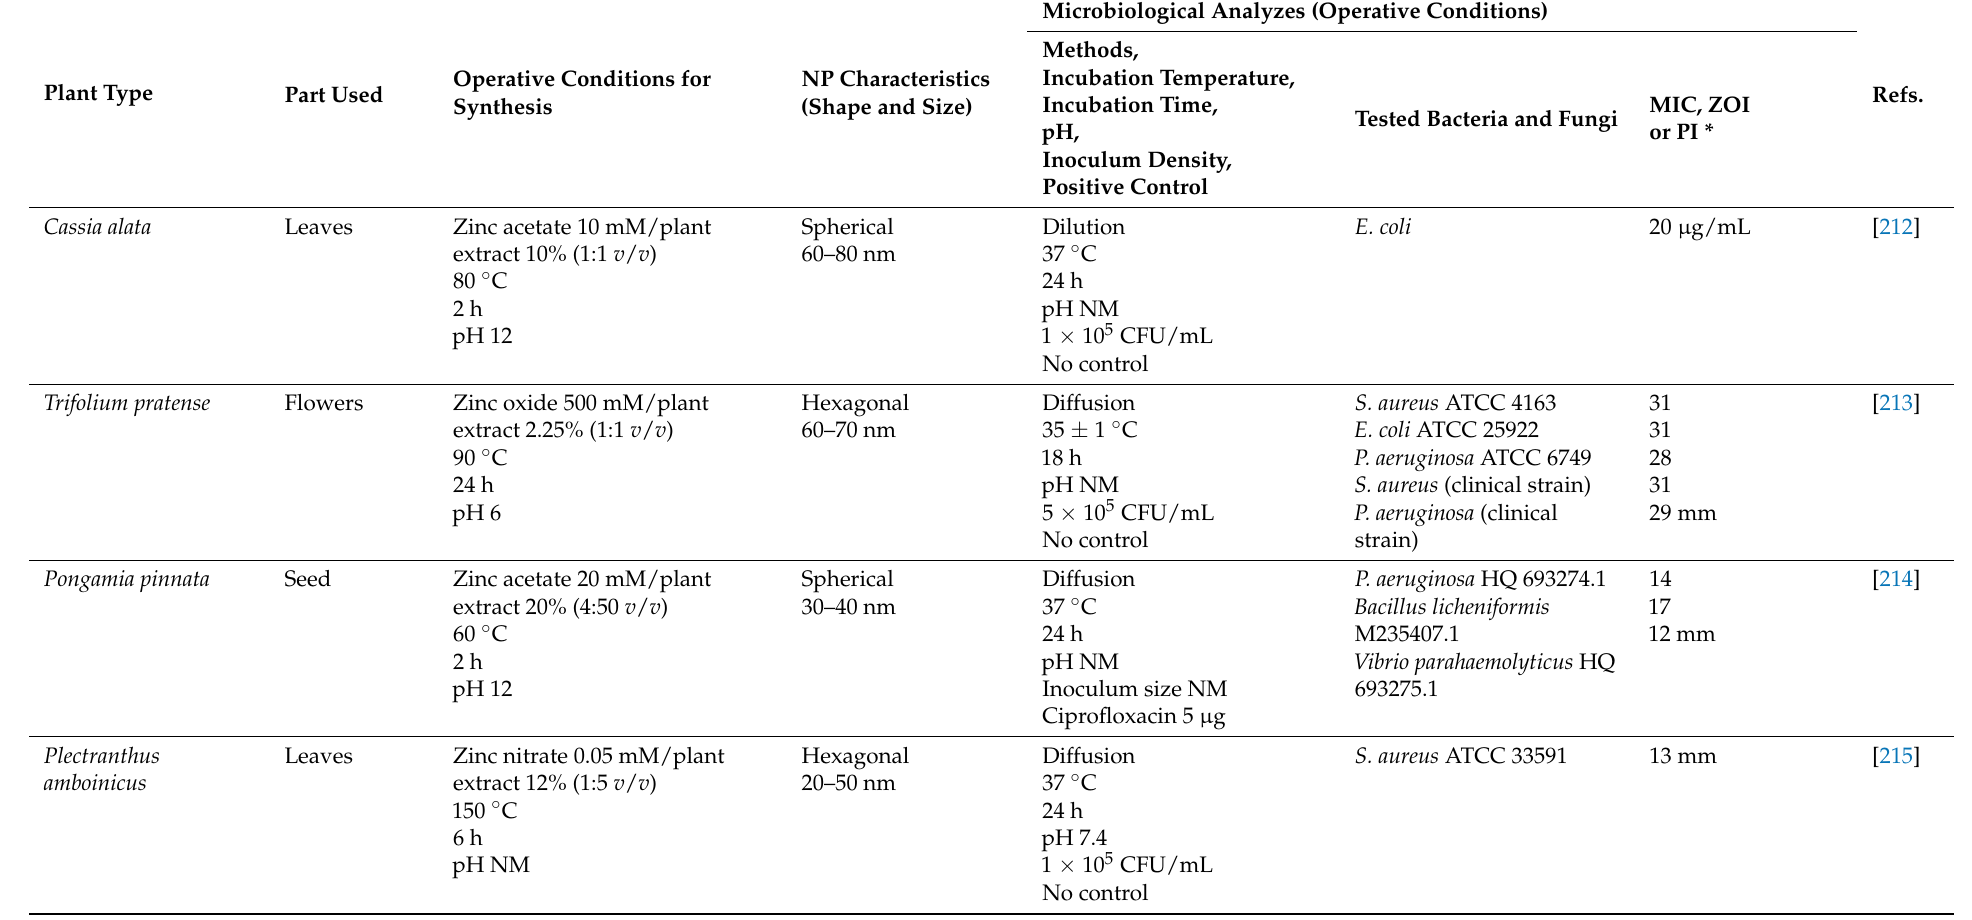
Table 4. Antimicrobial green-synthesized zinc oxide